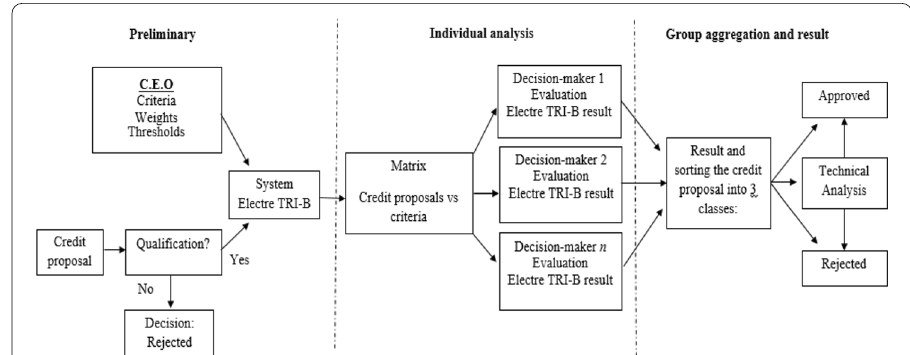
Fig. 1 The operational flow of the proposed